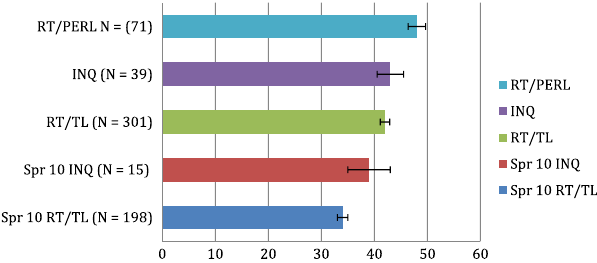
FIG. 3. Algebra-based MBT post by laboratory and teaching style. The data are listed by laboratory/teaching